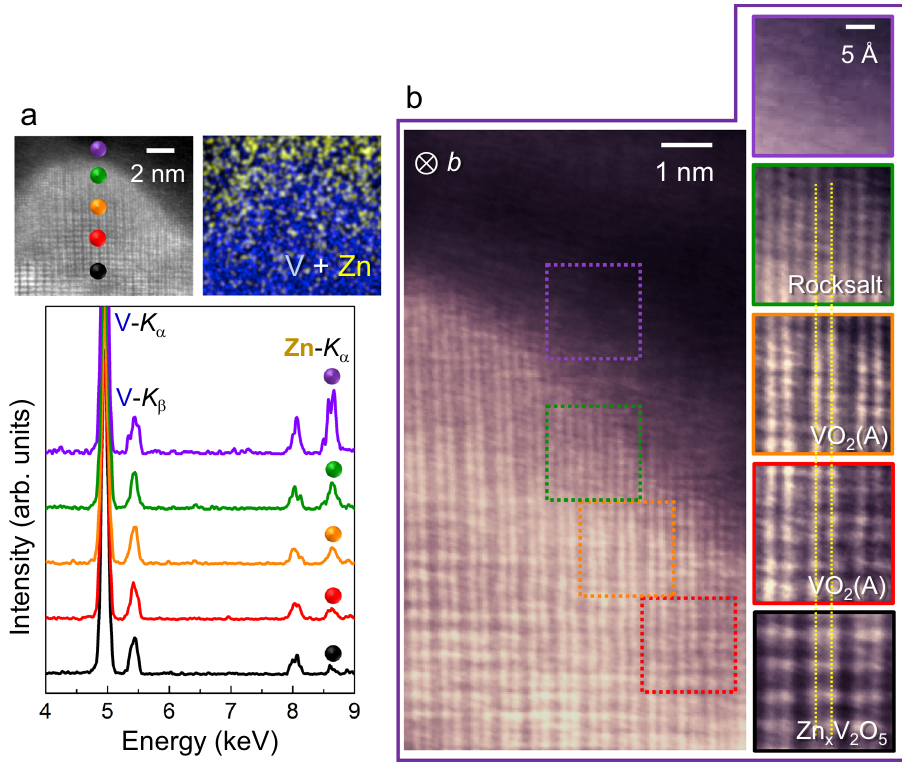
Fig. 6 Smooth transformation behavior during Zn insertion in the b projection. a As denoted by small spheres in color in the image, gradual increase in Zn concentration near the grain-boundary in a sample discharged to 0.77 V is veri fi ed in a series of EDS spectra along with the compositional map. b The magni fi ed ADF image and the enlargements for the local regions denoted by squares demonstrate the structurally smooth and continuous phase transition without showing abrupt lattice discontinuity. A pair of yellow lines on the enlargements directly indicates the continuous arrangement of atomic columns in the